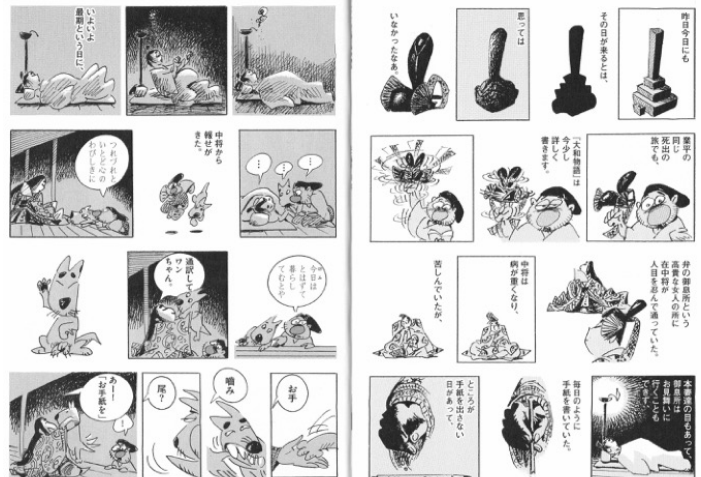
Figure 22. Kurogane Hiroshi. Ise monogatari (Tokyo: Shōgakukan, 2013), 288−289. Courtesy of Shōgakukan.